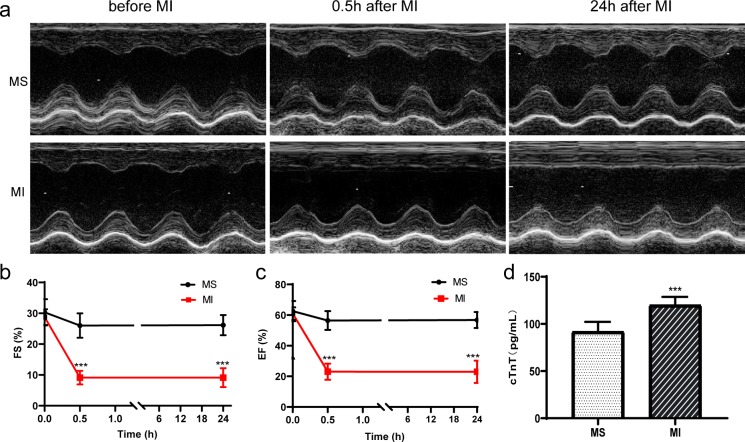
The change of left ventricular function and level of cTnT after MI (n = 10 each group).(a) Representative recording obtained from rats of MS and MI group at different timepoints. (b) FS of rats with MS and MI at different timepoints. (c) EF of rats with MS and MI at different timepoints. (d) Level of cTnT in the serum of rats MS and MI. All data are expressed as mean ± SD. ***P<0.001 vs MS group. MS: mock surgery, MI: myocardial ischemia.